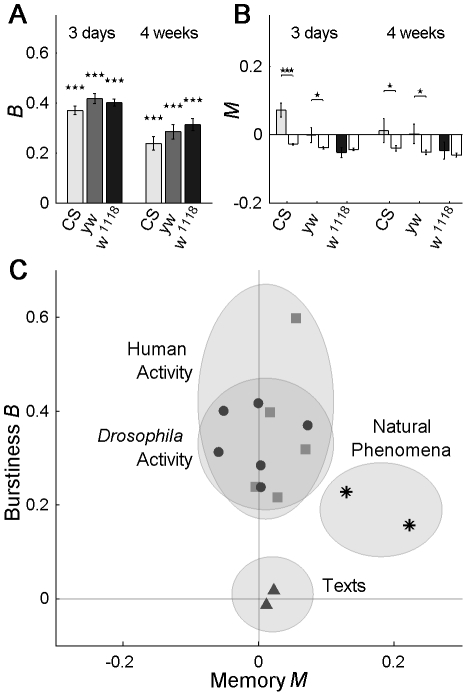

Drosophila burstiness is mainly due to the IAI distribution, and not to memory effects.(A) Burstiness parameter B for young (3 days, left) and adult (4 weeks, right) Canton-S (CS), yellow-white (yw) and w1118 flies, show bursty dynamics with B>0 (cf. Figure 1B), significantly different from the Poissonian B = 0 case with p<10−7. Older flies show a decrease of burstiness as compared to younger flies. (B) Burstiness of Drosophila IAIs has a small memory component. Significance levels are computed by comparison of actual and shuffled data (white bars). For the genetic background used in this study, w1118, there is no significant memory. Similar results are found for long-term memory, Figure S4. (C) Burstiness B and memory M are two different and independent burst-generating mechanisms, here represented in a plane and compared with data for human behavior dynamics, environmental phenomena and texts, taken from [8]. Drosophila dynamics fall in the same region as human dynamics, a region clearly separated from both environmental phenomena and texts. Figure S3 gives an overview of the total inter-activity intervals, shape and burstiness, as well as the corresponding values for total activity bout time, shape and burstiness. The same Drosophila data were used for Figures 1 and 2, number of flies n = 28–32. Error bars represent mean ± s.e.m.